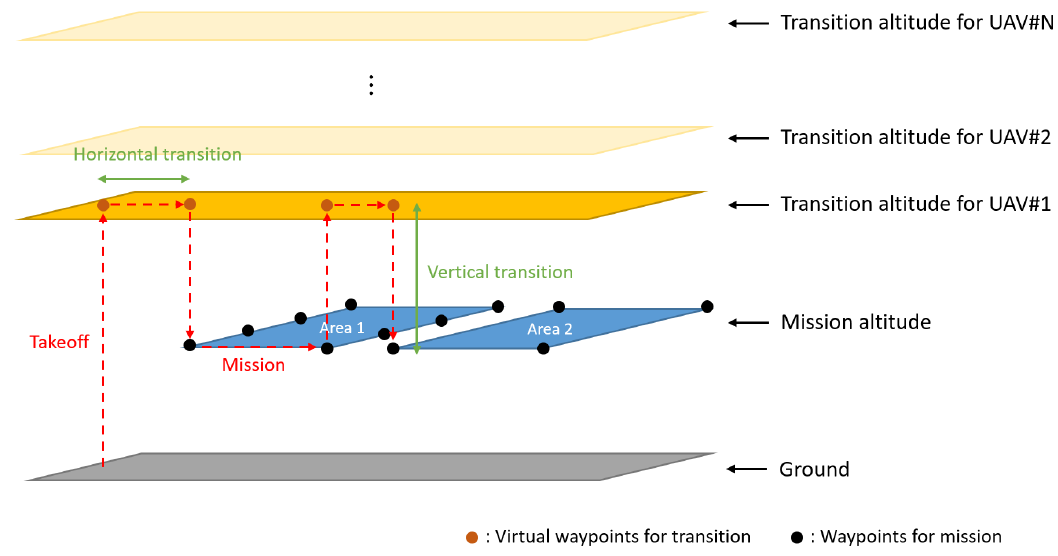
Figure 2. A concept of transition